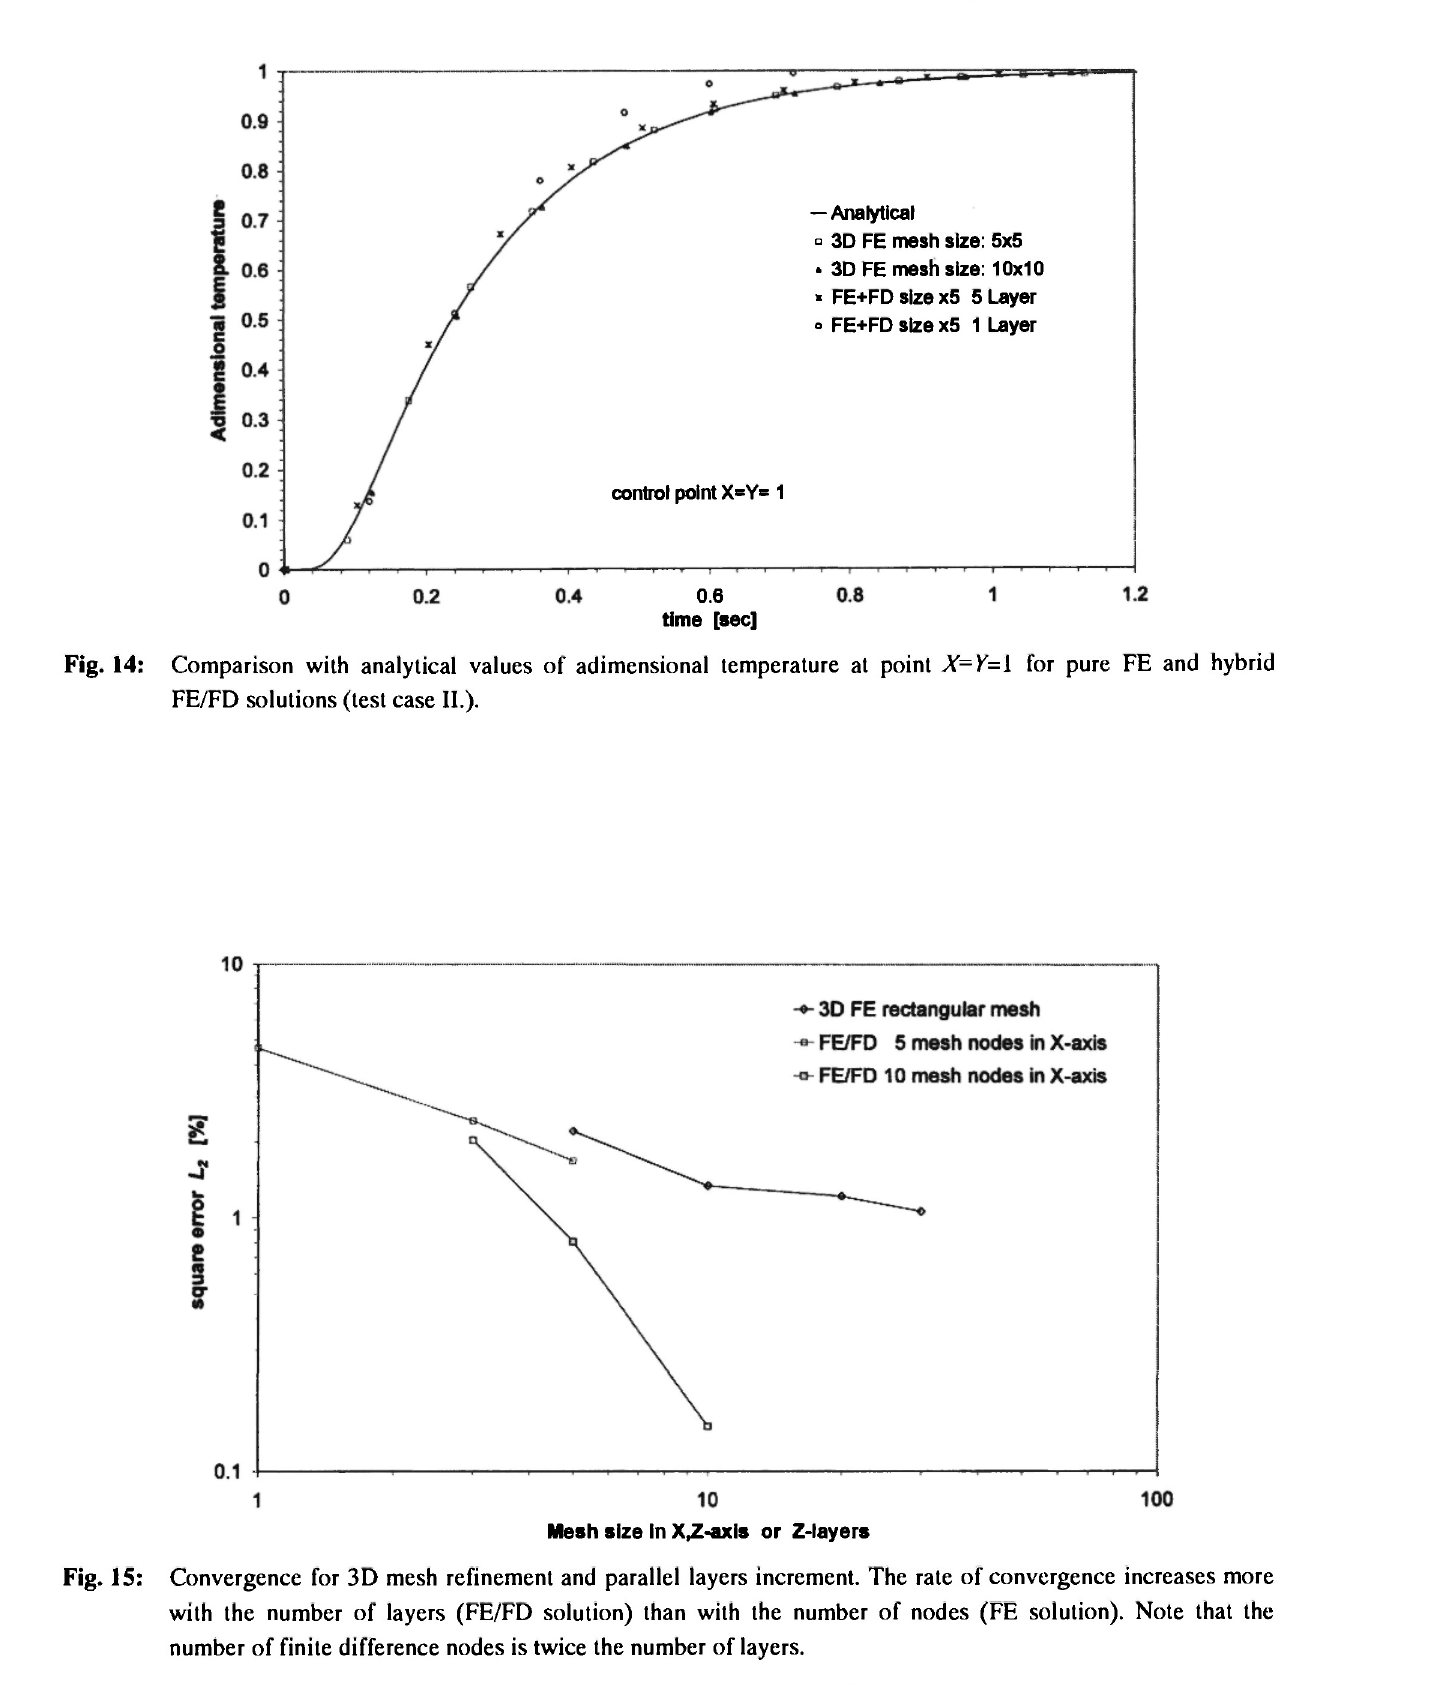
Fig. 15: Convergence for 3D mesh refinement and parallel layers increment. The rate of convergence increases more with the number of layers (FE/FD solution) than with the number of nodes (FE solution). Note that the number of finite difference nodes is twice the number of